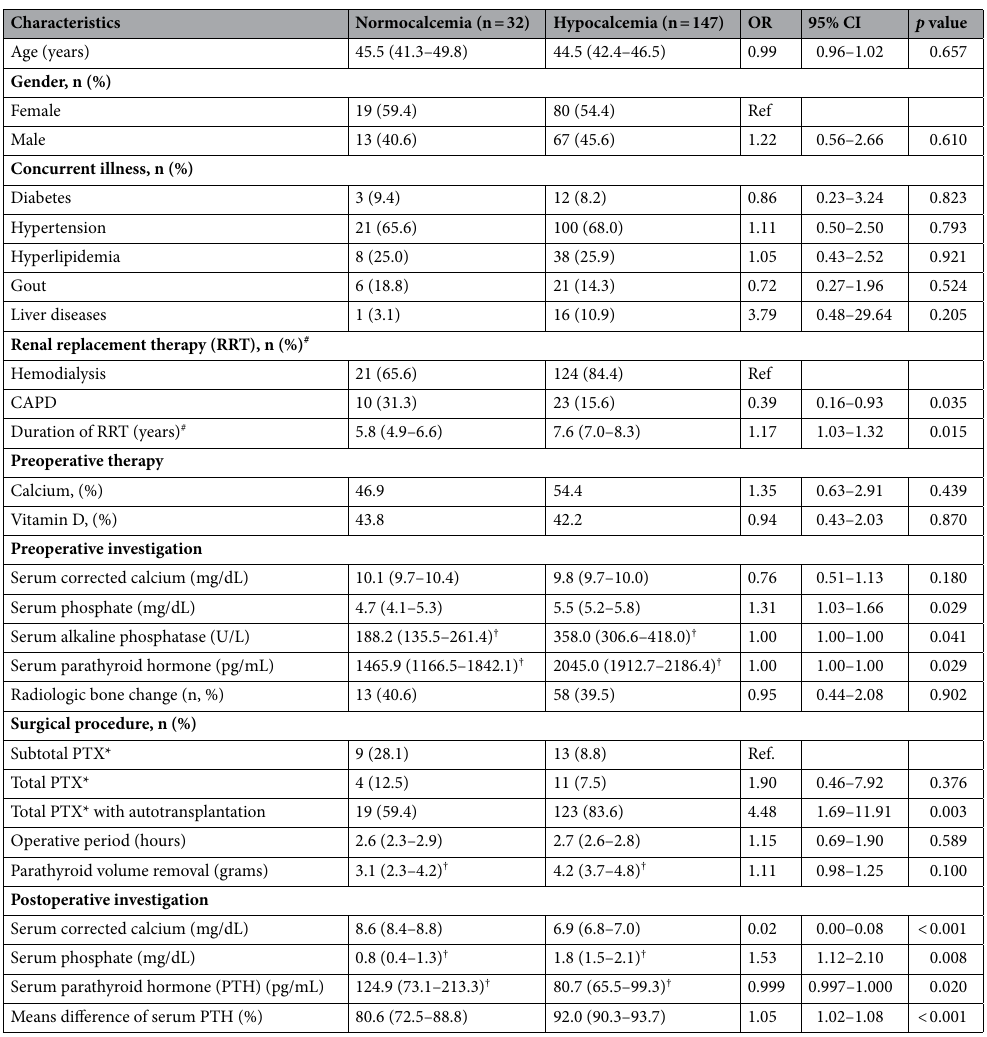
Table 1. Clinical characteristics of parathyroidectomy patients. # Analyzed data from 145 patients in hemodialysis group and 33 patients in CAPD group. * PTX parathyroidectomy, † data presented as Geometric mean (95% CI).